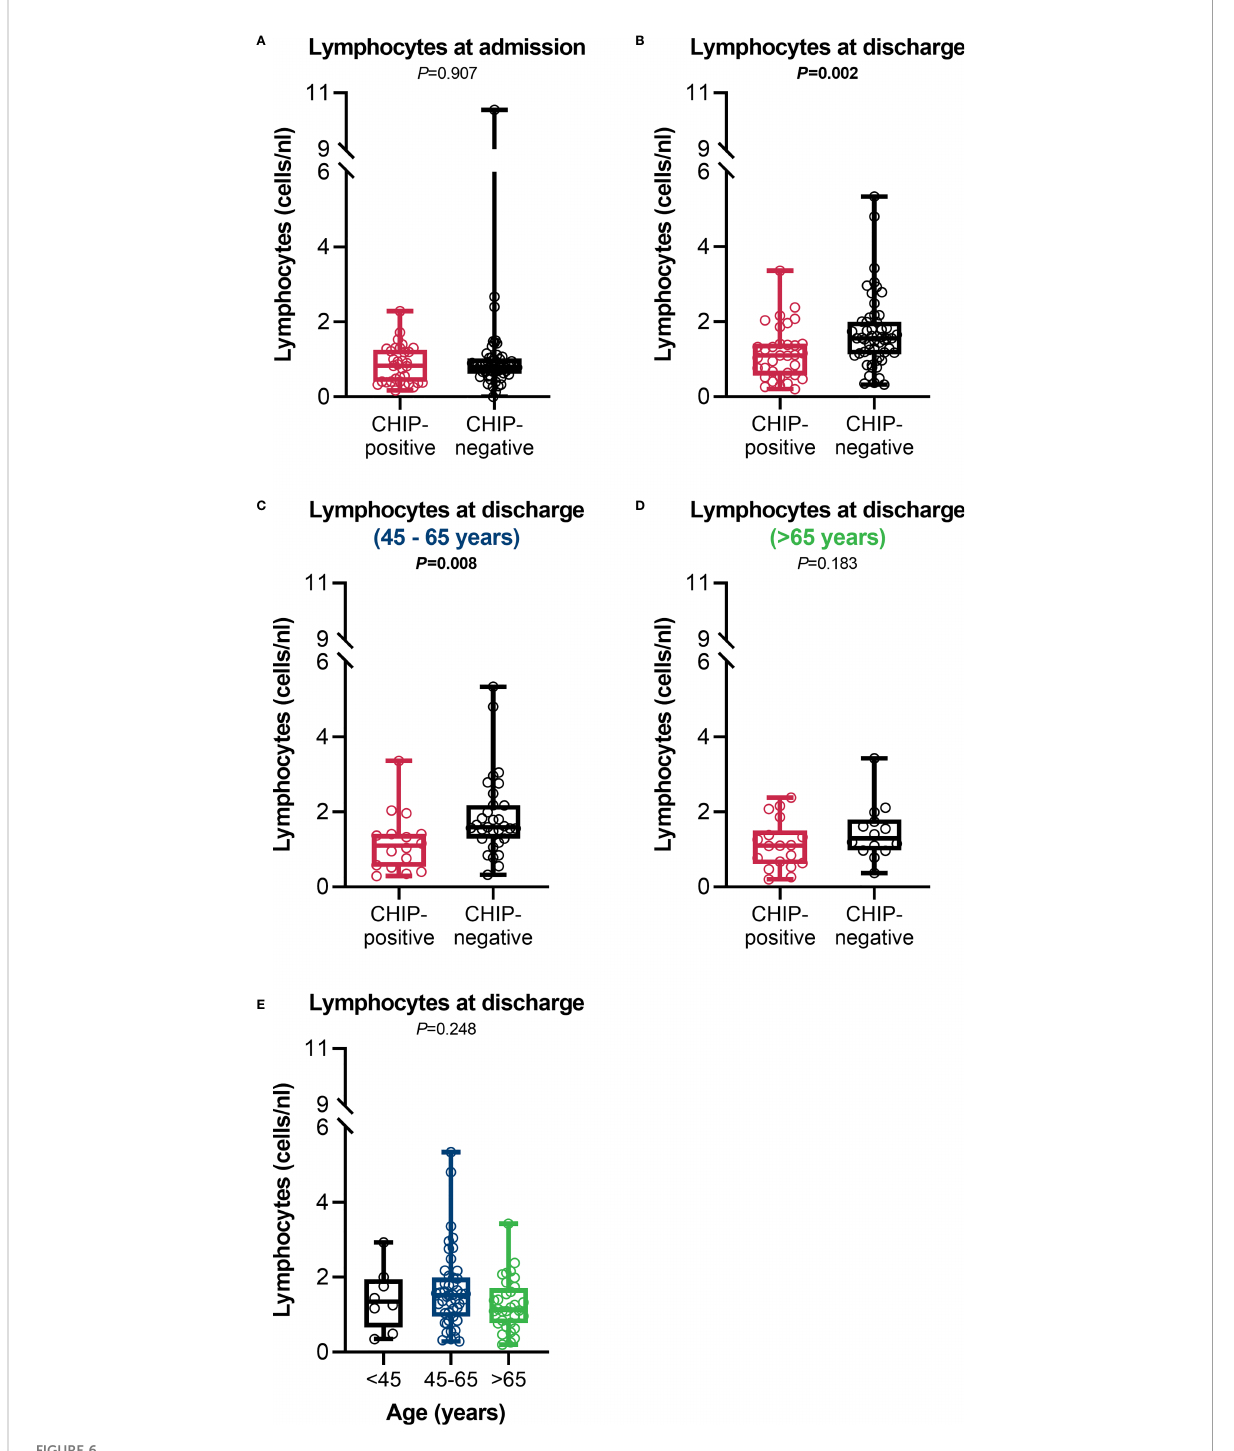
FIGURE 6 Lymphocyte counts. Lymphocyte counts at (A) admission (CHIP-positive: n=34; CHIP-negative: n=53) and (B) discharge (CHIP-positive: n=34; CHIP- negative: n=53). Lymphocyte counts at discharge for patients aged (C) 45 – 65 years (CHIP-positive: n=16; CHIP-negative: n=31) and (D) > 65 years (CHIP-positive: n=18; CHIP-negative: n=14). (E) Lymphocyte counts at discharge in comparison between the different age groups (<45: n=8; 45-65: n=47; >65: n=32). Group comparisons were performed by two sided (A – D) Mann – Whitney U-test or (E) Kruskal-Wallis test. Each data point represents an individual patient. Horizontal line within the box marks the median, boxes depict the IQR, and whiskers indicate the total range. Statistically signi fi cant results (P ≤ 0.05) are highlighted by bold